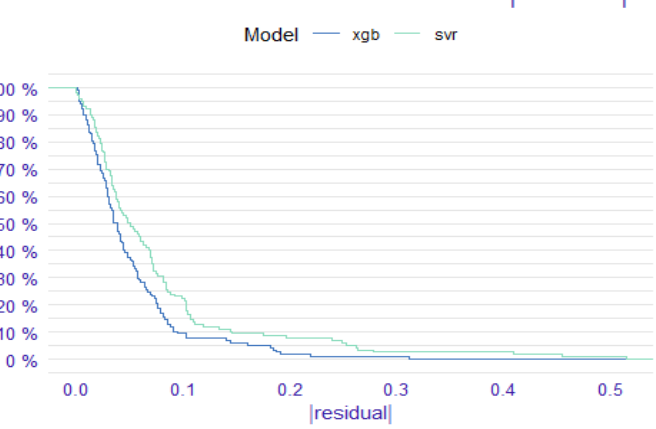
Figure 6. The reverse cumulative distribution of residuals during the COVID-19 period.